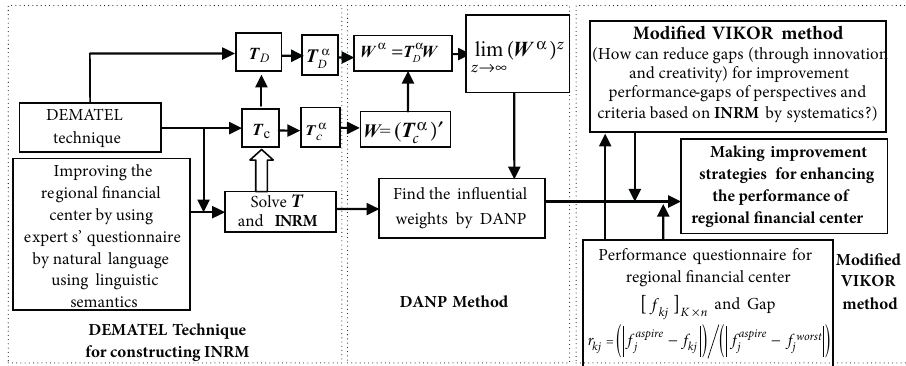
Fig. 1. Model procedure for new multiple attribute decision making for the regional financial center